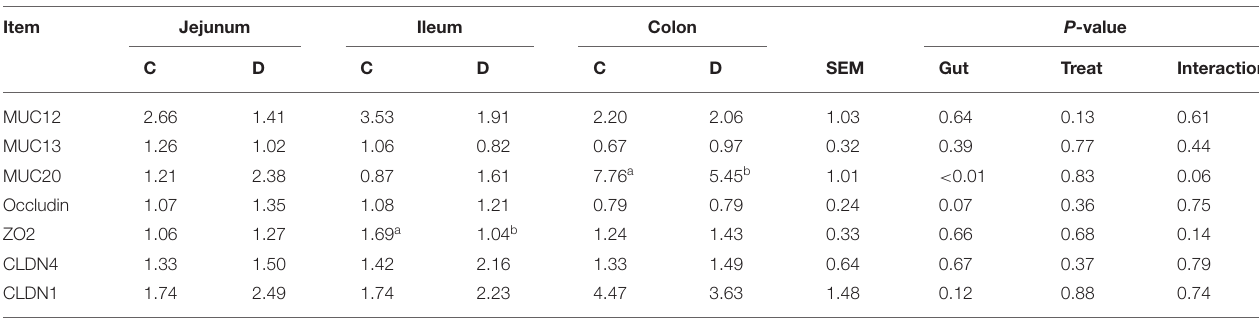
TABLE 3 | The expression of immune genes in the lower gut. Item Jejunum Ileum Colon P -value